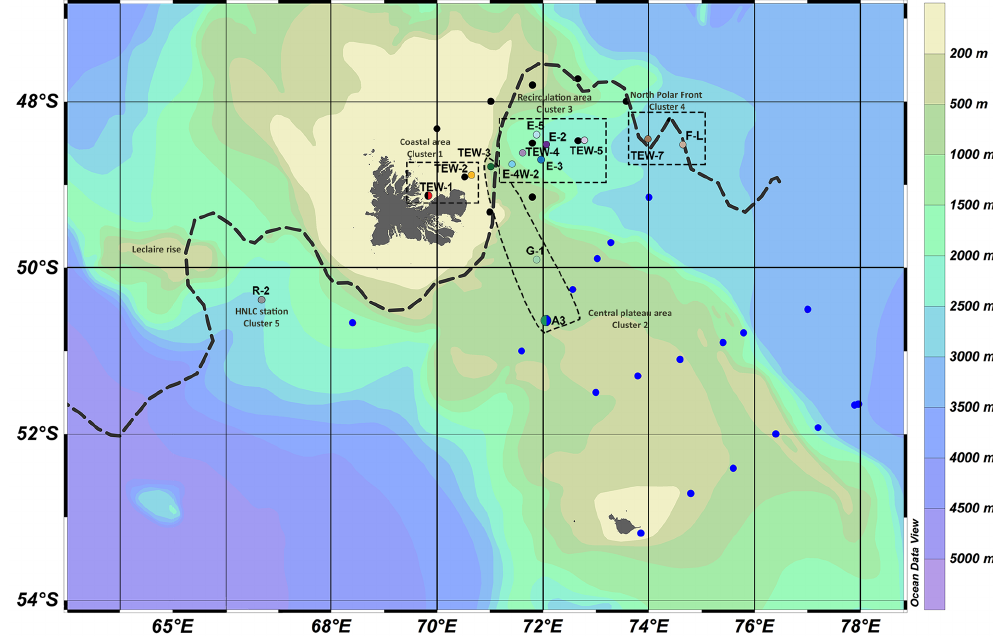
Figure 1. Map showing the bathymetry of the area and the stations visited during KEOPS2 (yellow-orange for cluster 1, green for cluster 2, blue-violet for cluster 3, brown for cluster 4, and grey for cluster 5), KEOPS1 (blue dots; Blain et al., 2008), and ANTARES3 (black dots; Bucciarelli et al., 2001). The dashed line represents the approximate location of the polar front (200m) (Park et al.,